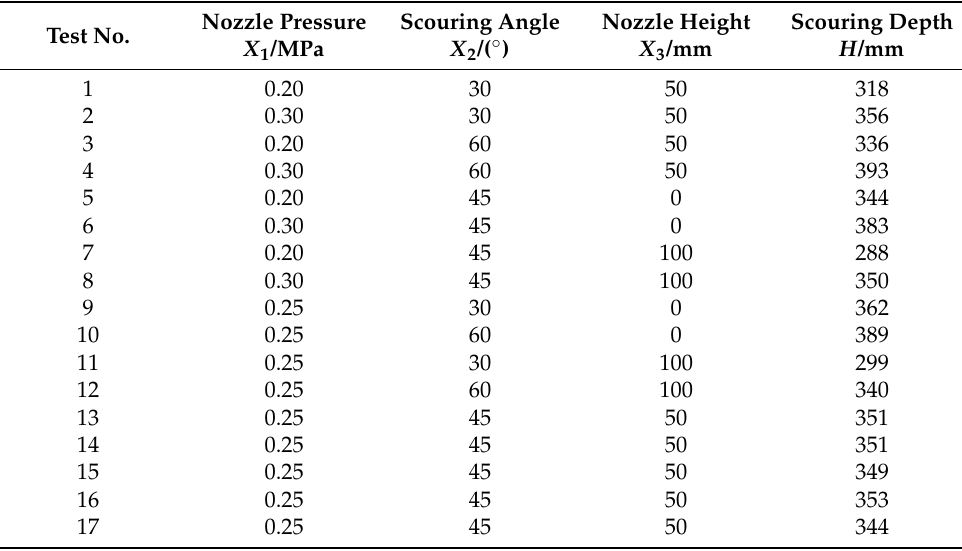
Table 10. Box–Behnken central combination design tests plan and